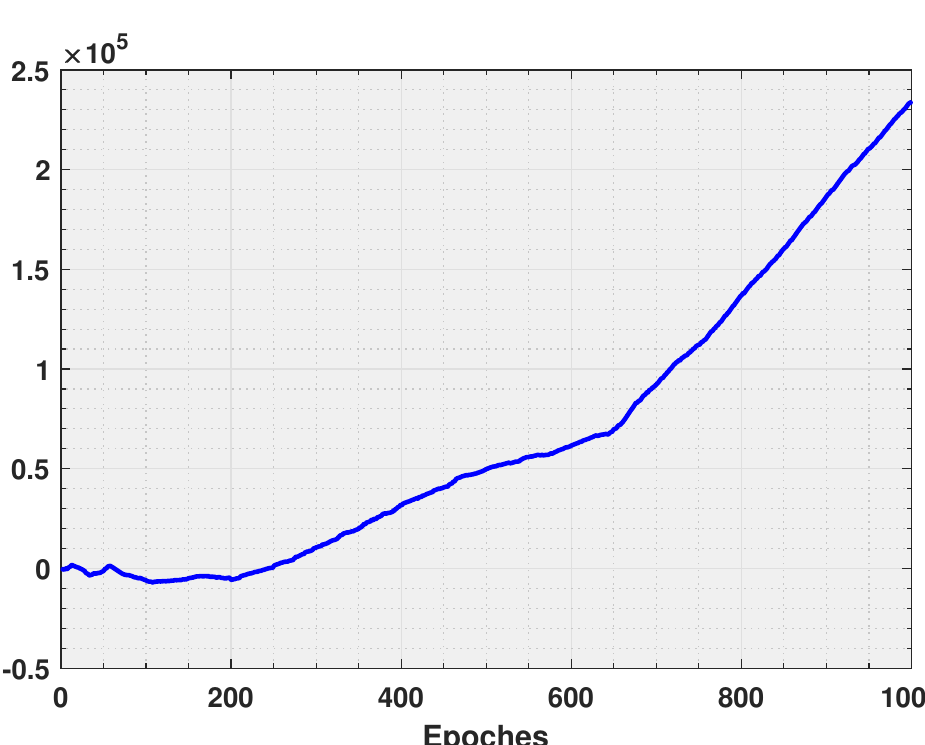
Figure 19. Reward accumulated throughout the training for the decision-making model